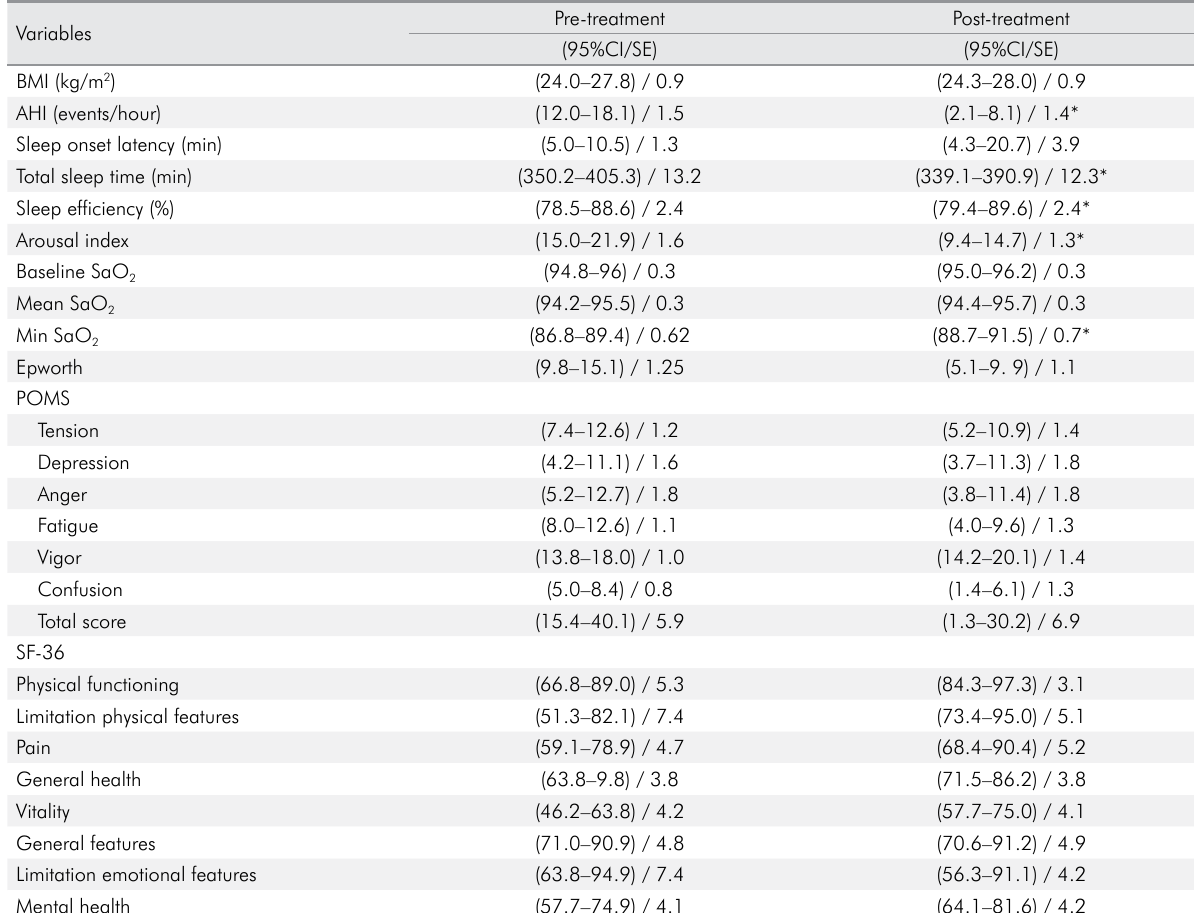
Table 2. All patients (n = 40) - Pre- and post-treatment